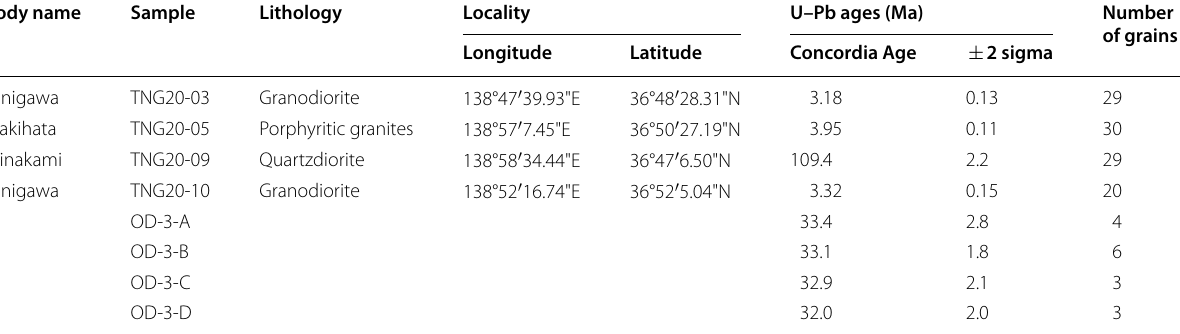
Table 1 Summary of dating